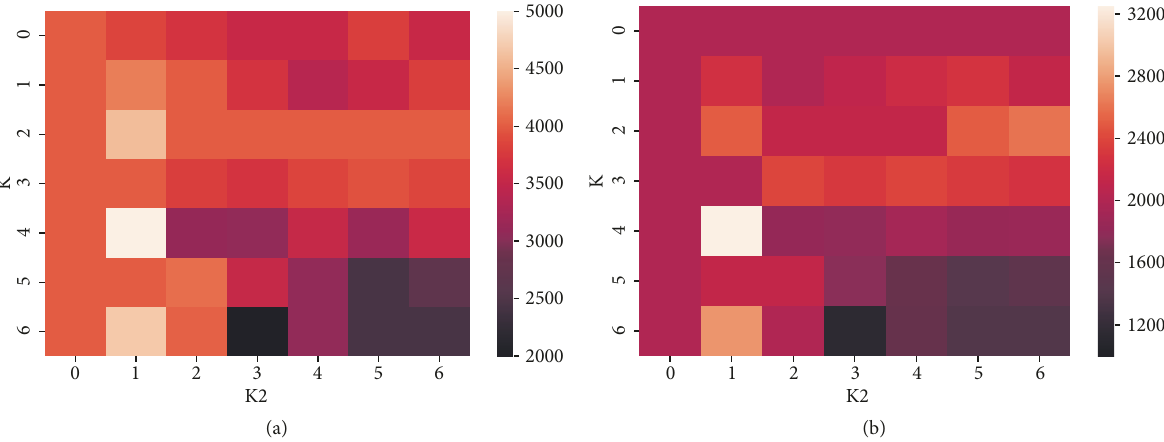
Figure 15: Heat maps showing the numbers of attractors depending on micro- and macro- K . (a) Macronetwork. (b) Micronetwork.